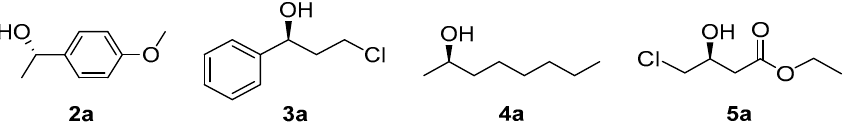
Figure 2. Examples of chiral alcohols that were obtained in alcohol dehydrogenase (ADH)-biocatalyzed processes in the presence of DES.